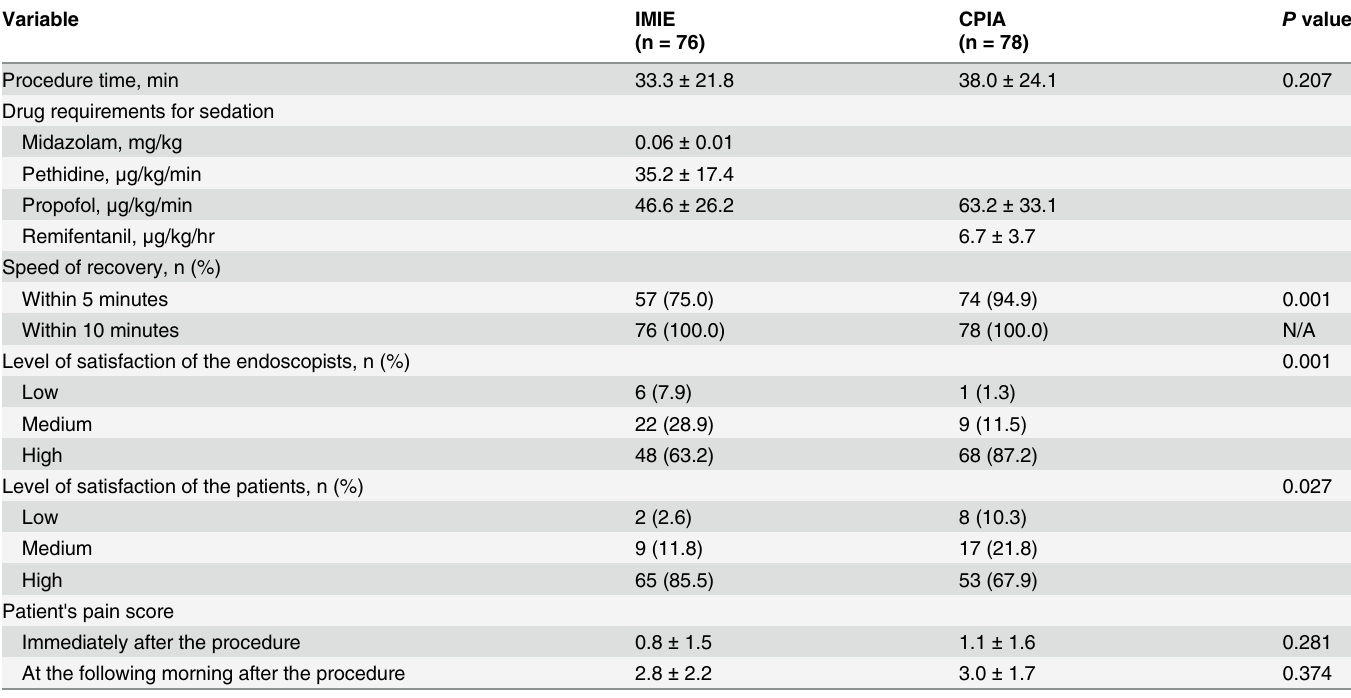
Table 4. Sedation-related data, speed of recovery and satisfaction scores.